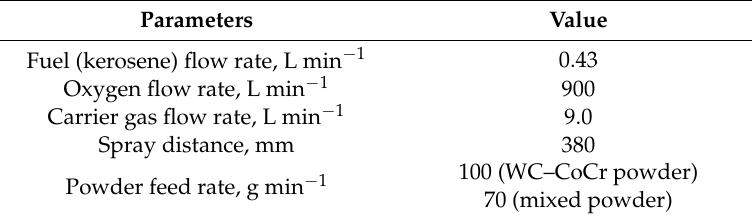
Table 1. HVOF spraying